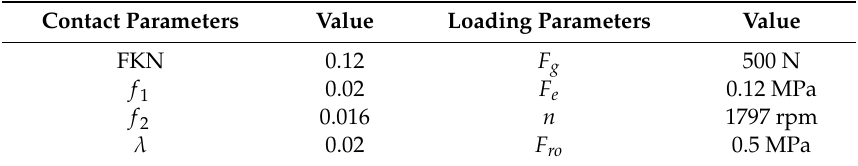
Table 3. Contact parameters and loading parameters for the FEM